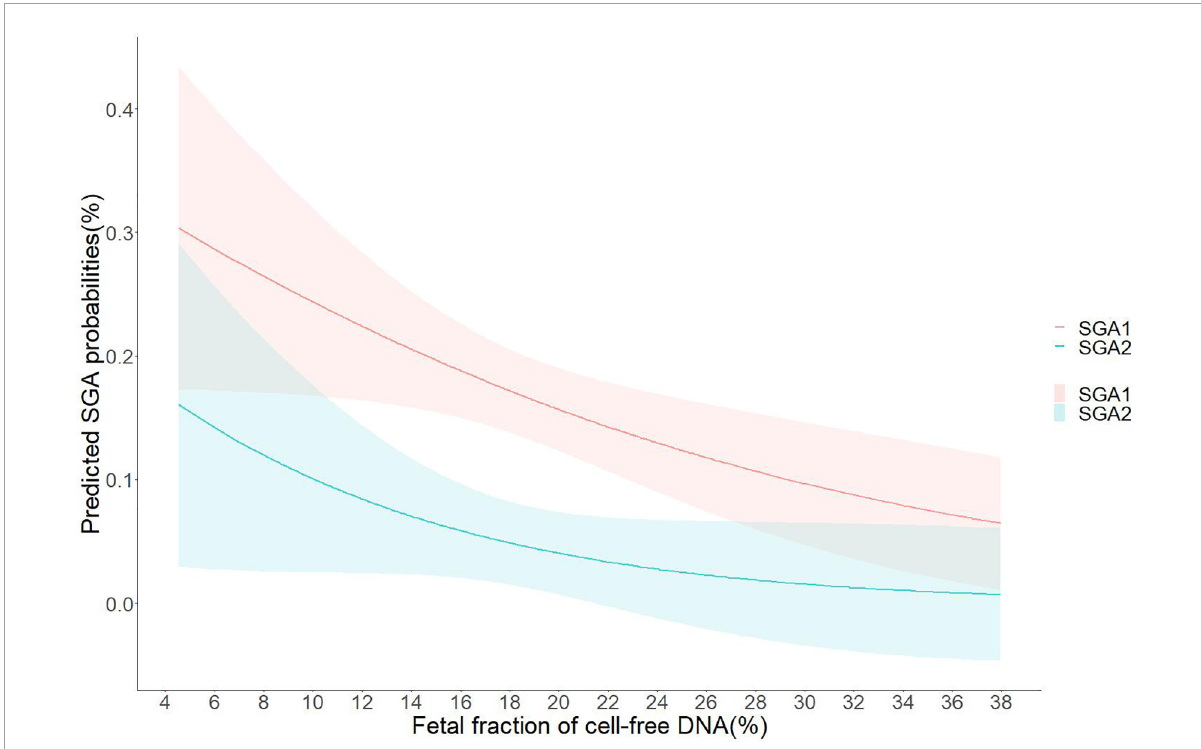
FIGURE3 Predicted small for gestational age (SGA) probabilities with 95% CIs were calculated with respect to fetal fraction (FF) by performing logistic regression models; SGA1, at least one fetus of twins developed small for gestational age; SGA2, both fetuses of twins developed small for gestational